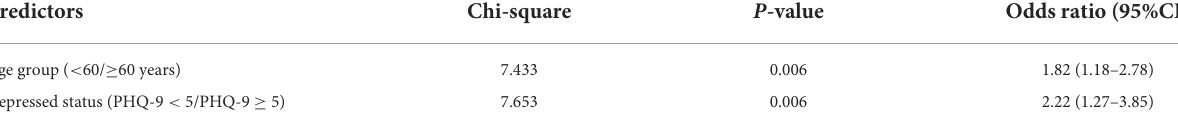
TABLE 3 Overall logistic regression model based on significative factors for predicting re-positivity.